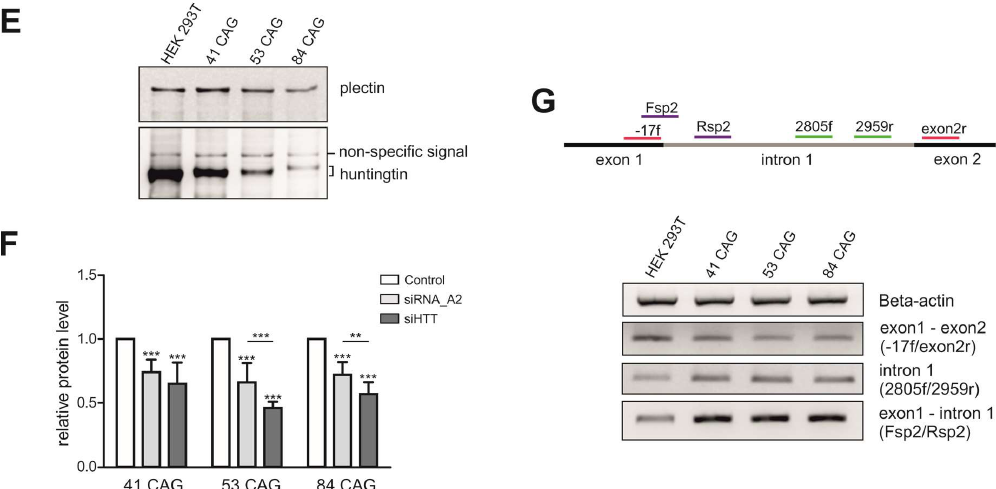
Figure 1. Generation of HEK 293T monoclonal cell lines with different numbers of CAG repeats at the HTT locus . ( A ) Successful strategy used to generate three monoclonal cell lines: 41 CAG, 53 CAG and 84 CAG. HTT_sg3 and SpCas9 were used to create DSB upstream from the CAG repeats. A linearized plasmid containing 41, 53 or 84 CAG repeats and silent mutation in a PAM sequence that doesn’t lead to an amino acid change (marked in green) served as a donor template for HDR. ( B ) Schematic representation of procedures used to generate HEK 293T cells with biallelic mutation at the HTT locus . ( C ) RT-PCR analysis of the edited HTT gene fragment containing 41, 53 or 84 CAG repeats. The PCR product comprises CAG repeat tract. Unmodified HEK 293T cells contain 16/17 CAG repeats at the HTT locus . ( D ) RT-qPCR analysis of the HTT mRNA level in 41 CAG, 53 CAG and 84 CAG cell lines. PCR primers were located downstream (3′ CAG) from the CAG repeats. All samples were normalized to β-actin, and the results are the mean (± SEM) relative to unmodified HEK 293T cells ( n = 3; one-way ANOVA followed by Bonferroni’s post hoc test; * p = 0.01 to 0.05, ** p = 0.001 to 0.01, *** p < 0.001). ( E ) Western blot analysis of the huntingtin level in the edited cell lines and ( F ) cells transfected with the siRNA_A2 and siHTT. Plectin was used as a loading control. The results indicate the mean (± SEM) relative to cells treated with the control siRNA (BlockIT) ( n = 3; one way ANOVA followed